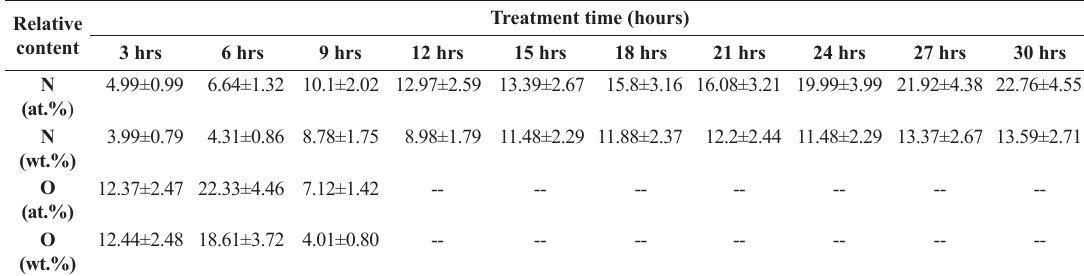
Table 1. Energy dispersive x-ray spectroscopy data showing the variation of nitrogen and oxygen content (at. % & wt. %) in samples nitrided for various treatment times at optimum fill pressure of 0.5 mbar. Relative